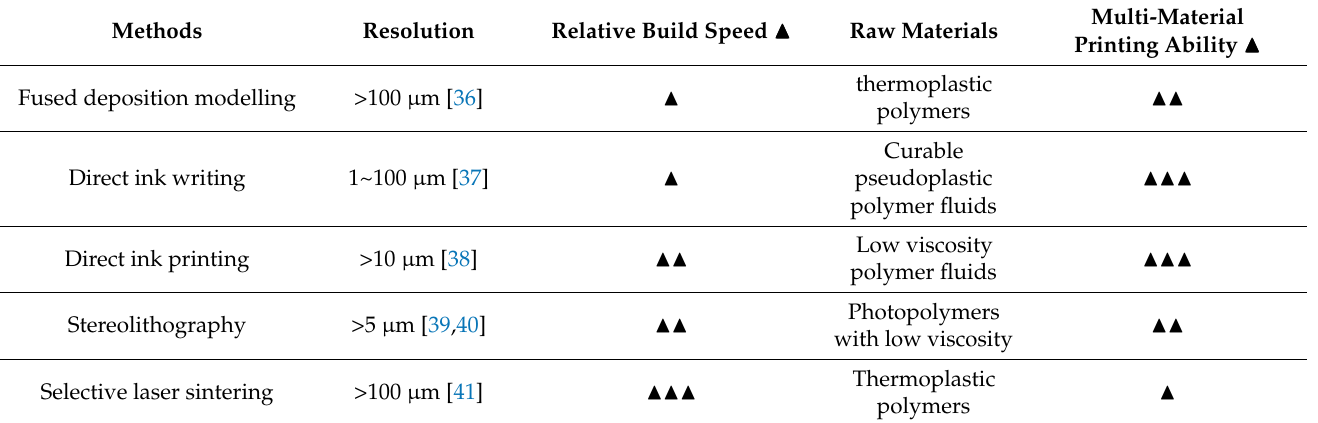
Table 1. Comparison of different 3D printing